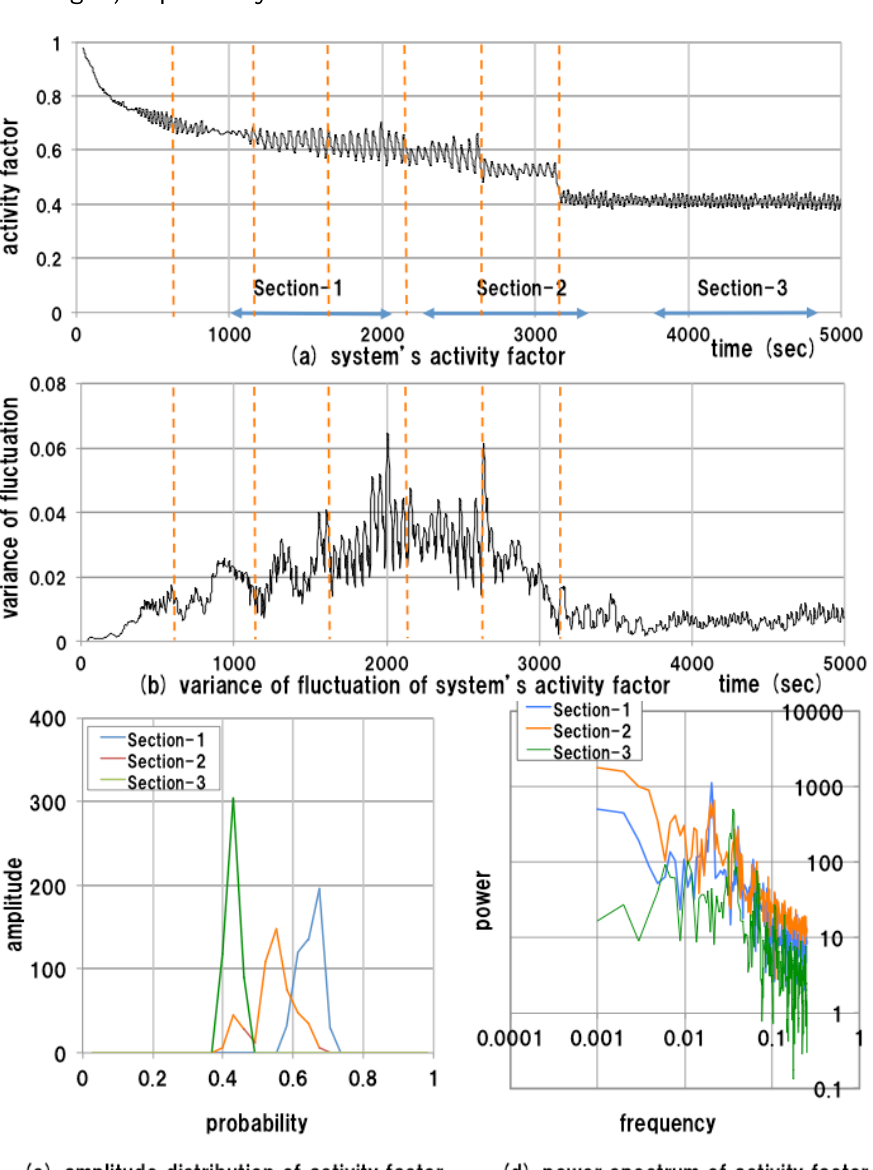
Figure 8. Results of measurements of the changed test bed